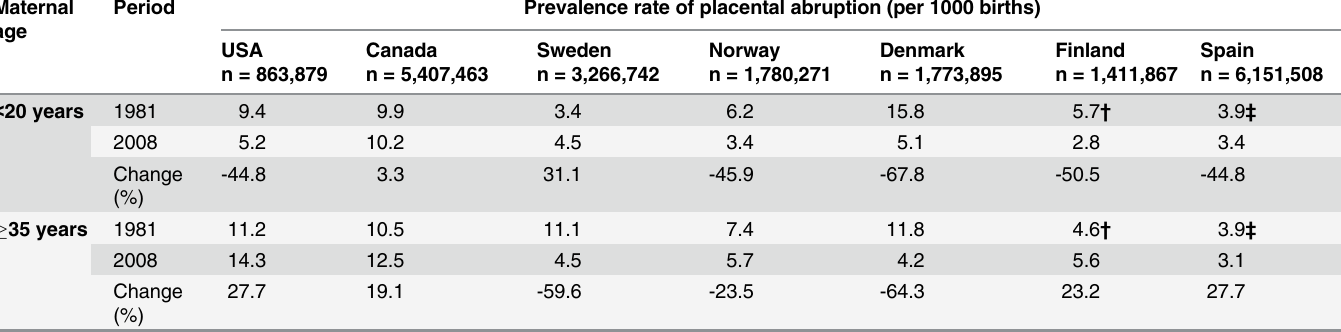
Table 1. Changes in the prevalence of placental abruption based on maternal age in each country. Maternal age